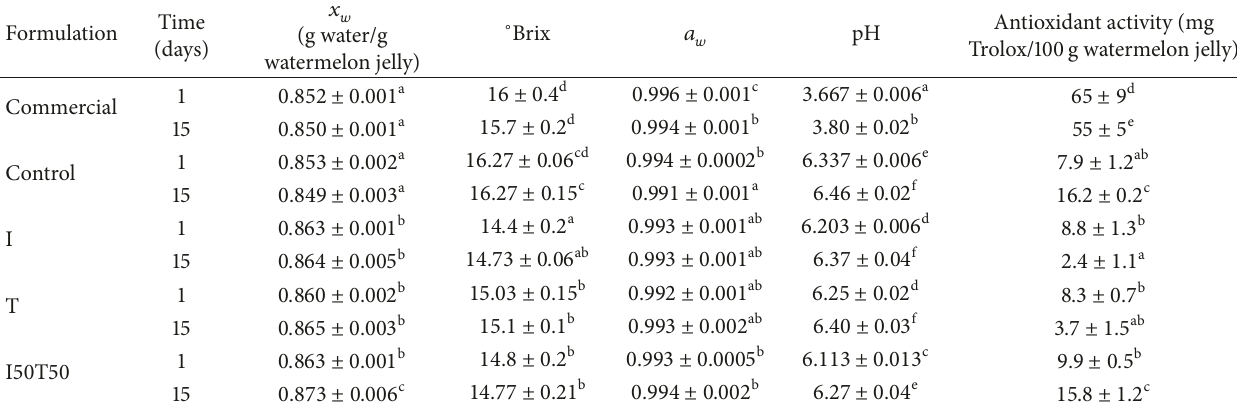
Table 1: Values for moisture content ( 𝑥 𝑤 : g water/g watermelon jelly), ∘ Brix, water activity ( 𝑎 𝑤 ), pH, and antioxidant activity (mg Trolox/100 g watermelon jelly) of watermelon jelly formulated with sucrose (control and commercial) or with sweeteners (isomaltulose and tagatose), initially and after 15 days of